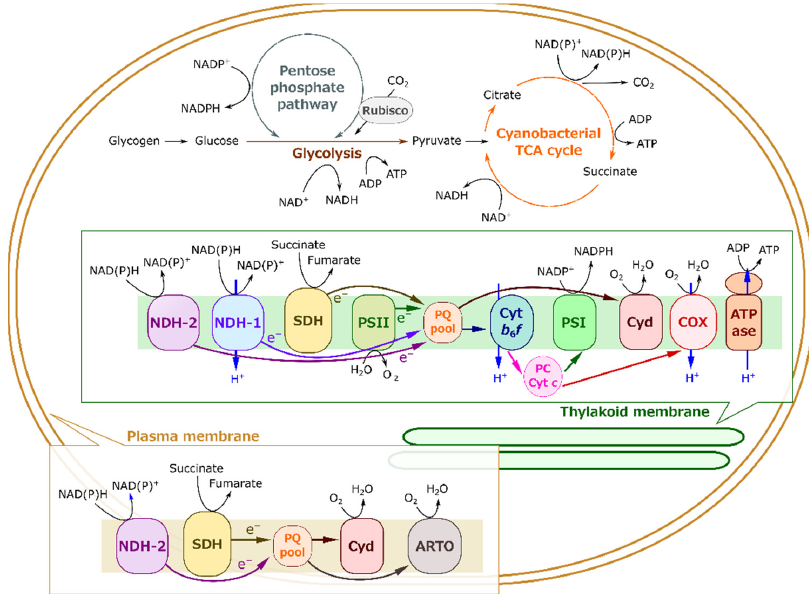
Figure 1. A brief illustration of respiration and photosynthesis sharing their metabolisms and electron transport chains in one cyanobacterial cell. To simplify the illustration, stoichiometry of each reaction and many bypasses are disregarded here. The direction of the arrows mainly follows the respiration mode. Under light conditions, photosynthetic electron transport proceeds from PSII to PSI, and Rubisco assimilates CO 2 to initiate the reductive pentose phosphate pathway (also called the Calvin–Benson cycle). Conversely, the oxidative pentose phosphate pathway proceeds in sugar catabolism, producing reducing power as NADPH. Abbreviations for enzymes and the complexes are as follows: Rubisco, ribulose 1,5-bisphosphate carboxylase/oxygenase; NDH-1 and -2, type I and II NAD(P)H dehydrogenase; SDH, succinate dehydrogenase; PSII and PSI, photosystem II and I; PQ, plastoquinone; Cyt b 6 f , cytochrome b 6 f complex; PC, plastocyanin; Cyt c , cytochrome c ; Cyd, cytochrome bd -type quinol oxidase; COX, cytochrome c oxidase; ATPase, ATP synthase; ARTO, alternative respiratory terminal oxidase.